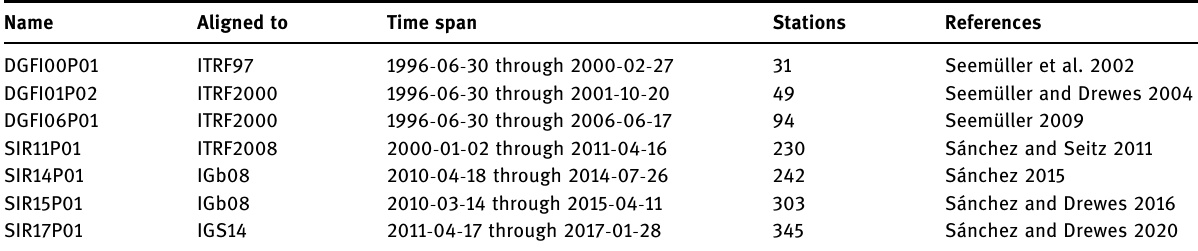
Table 1: Selected multi - year SIRGAS station position and velocity solutions computed by